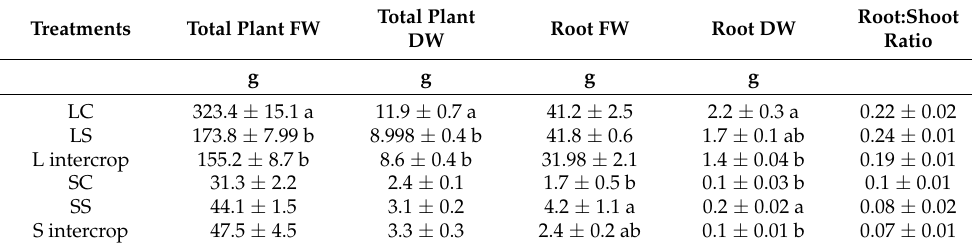
Table 2. Growth of L. sativa and S. soda plants in terms of both fresh and dry biomass at the end of the 30-day